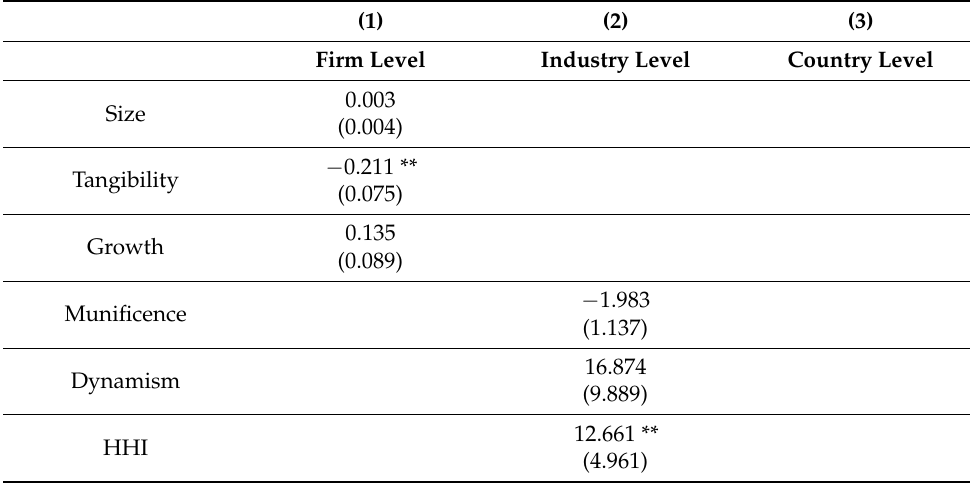
Table A5. Robustness: Driscoll–Kraay regression